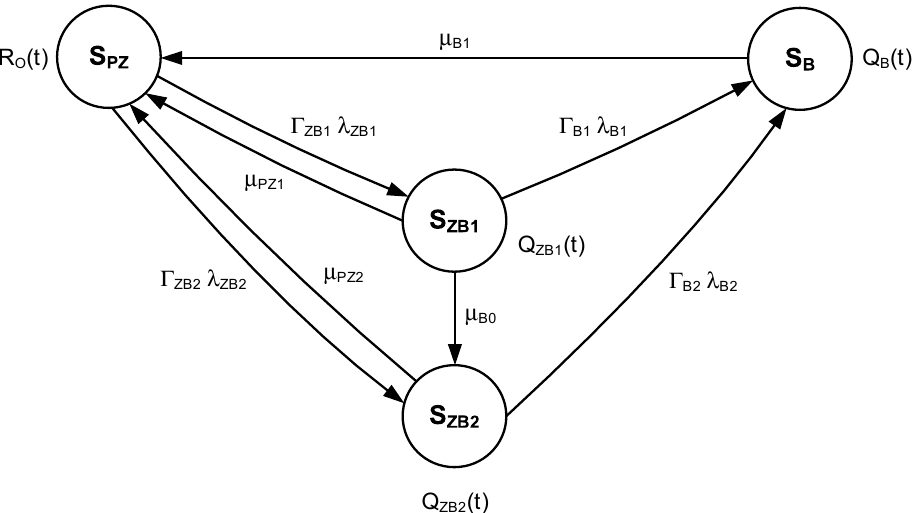
Figure 15. A graph illustrating the impact of emitted radiated interference generated by a rail traction vehicle on a trackside video monitoring system.